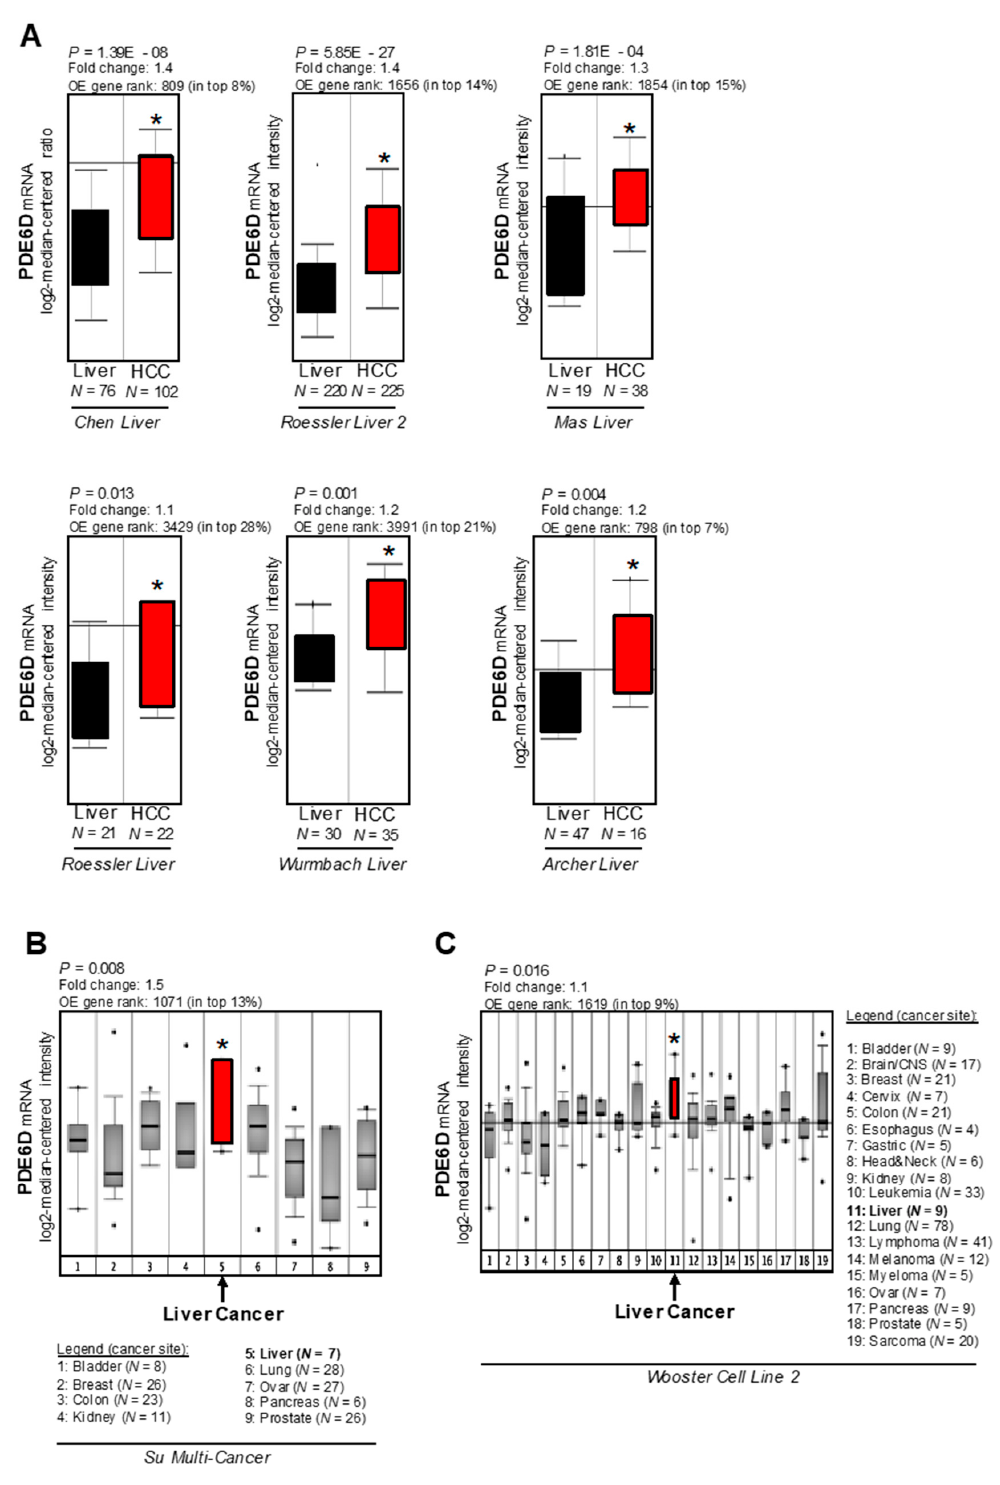
Figure 1. In silico analysis of rod-specific photoreceptor cGMP phosphodiesterase (PDE6D) expression in hepatocellular carcinoma (HCC). ( A ) Oncomine TM human cancer microarray database analysis of six patient datasets depicting PDE6D mRNA expression levels in HCCs and non-tumorous livers (* p < 0.05 vs. non-tumorous livers). ( B , C ) Oncomine TM human cancer microarray database analysis of PDE6D expression as detected in large-scale RNA profiling studies comparing diverse carcinomas of different origins (* p < 0.05 vs. average expression).